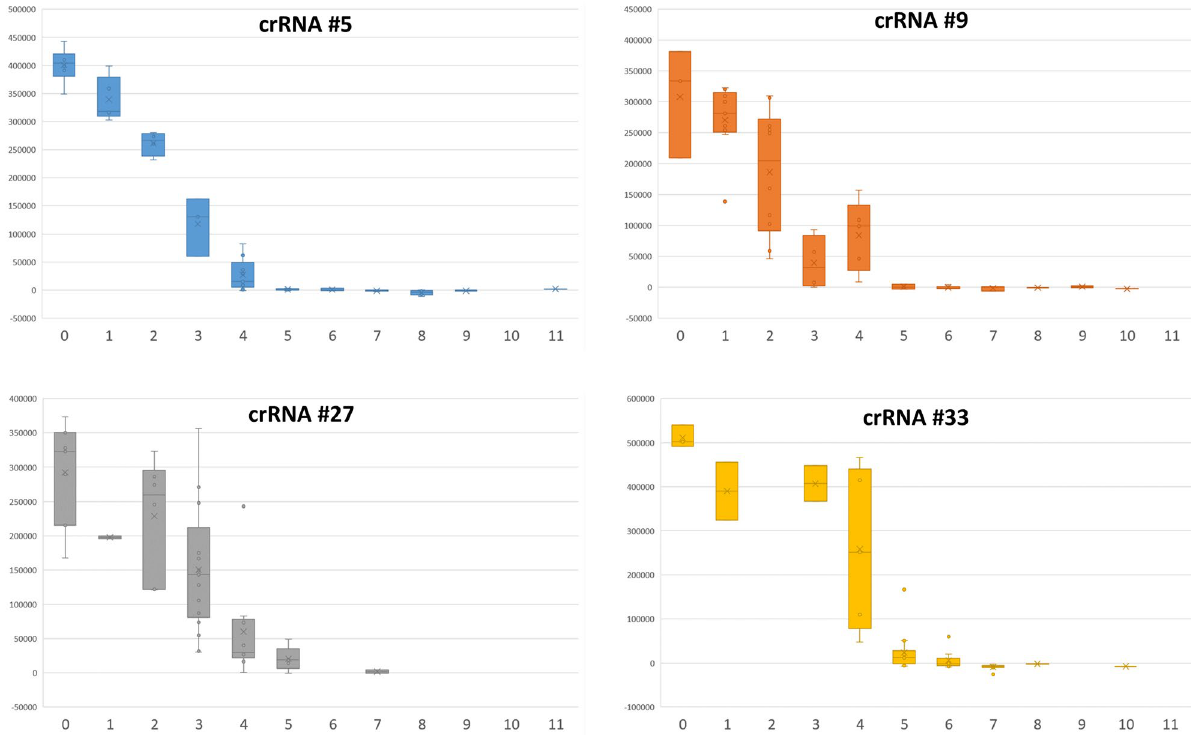
Figure 3. Relationship between spacer/target mismatch number (x-axis) and Cas13a assay fluorescent signal (y-axis). Relationship between the number of mismatches of the spacer/target pairs (for Watson–Crick pairing rules) and the cumulative background subtracted fluorescence signal obtained in Cas13a assay for all the spacer/target pairs tested for L gene crRNAs #5, #9, #29 and